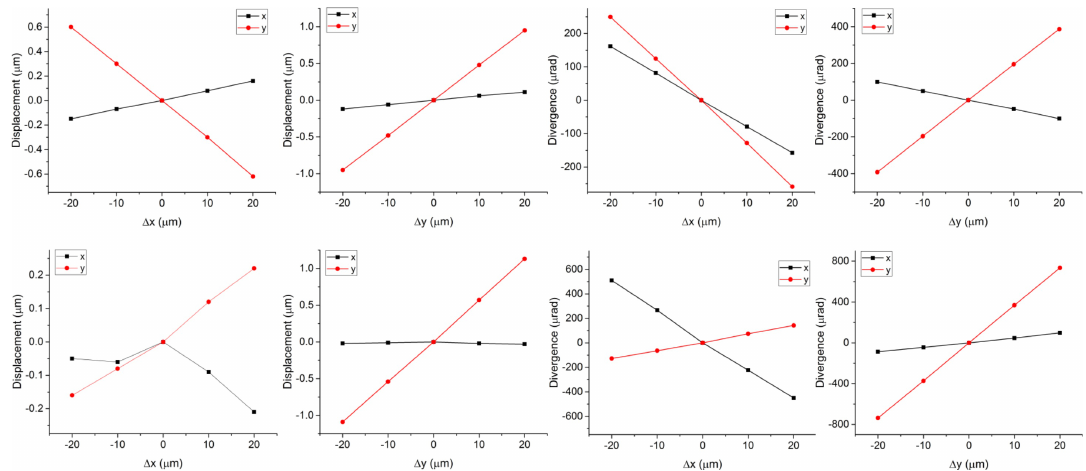
Figure 13. Displacement and divergence of the beam at the injection point as a function of the laser displacement at the photocathode for WP2 ( upper row ) and WP4 ( lower row ) of the ARES linac. For both WP2 and WP4 Flat-Top transverse laser profile and Gaussian longitudinal laser profile were used. The RMS laser spot-size were 0.18 mm (WP2) and 0.17 mm (WP4), while the laser RMS duration were 3 ps (WP2) and 290 fs